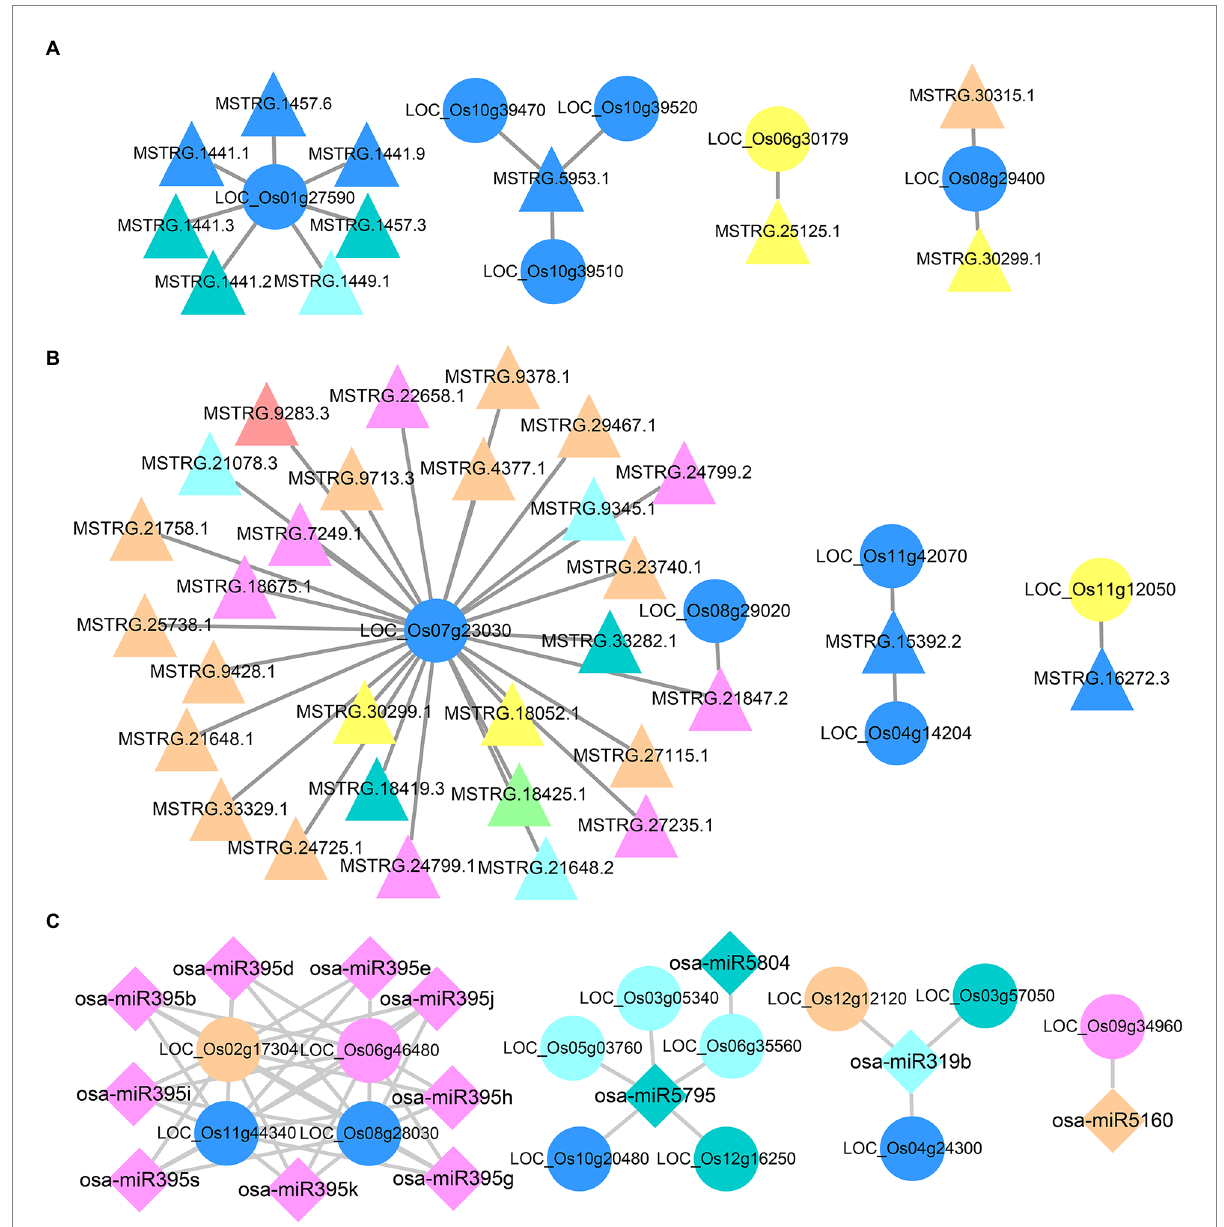
FIGURE 6 Regulatory networks of DElncRNAHPs and DEmiRNAHPs on their target DEGHPs. (A) Regulatory network of DElncRNAHPs on their cis target DEGHPs. (B) Regulatory network of DElncRNAHPs on their trans target DEGHPs. (C) Regulatory network of DEmiRNAHPs on their target DEGHPs. The shapes and colors of the different types of RNA were consistent with those illustrated in Supplementary Figure